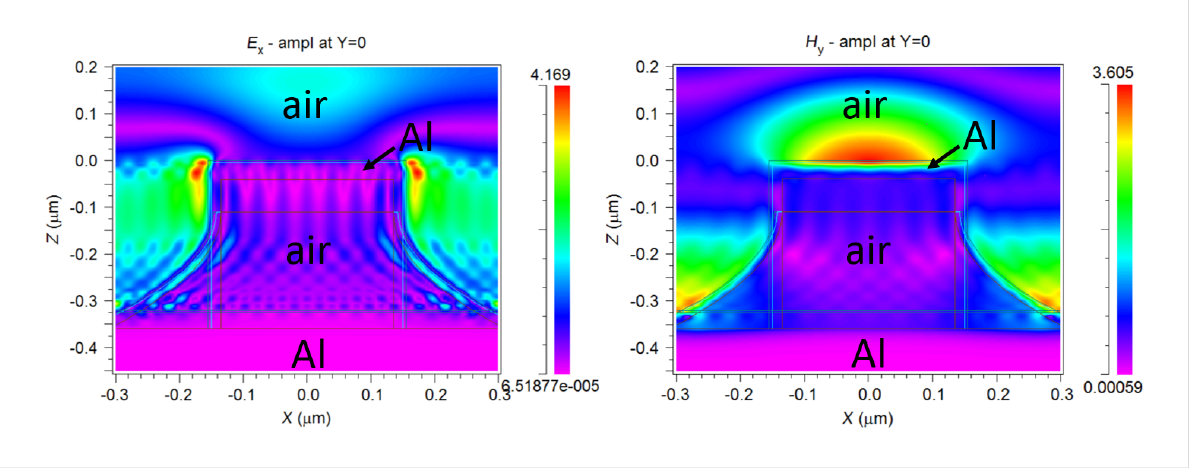
Figure 4: Calculated E x -field (right) and H y -field (left) distributions at λ = 700 nm (reflectance peak) in the x – z cross-section ( y = 0) of the unit cell of a hollow Al nanopillar array.